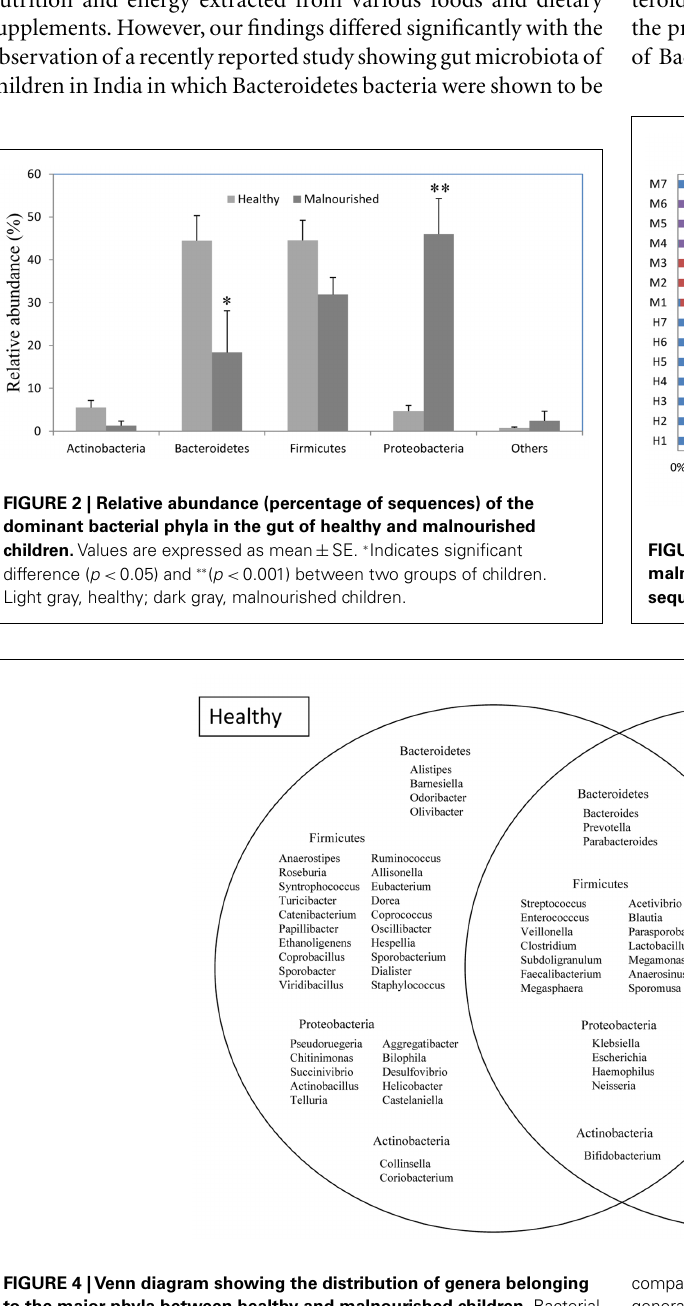
FIGURE 4 |Venn diagram showing the distribution of genera belonging to the major phyla between healthy and malnourished children. Bacterial genera with the relative abundance of ≥ 0.1% were considered for